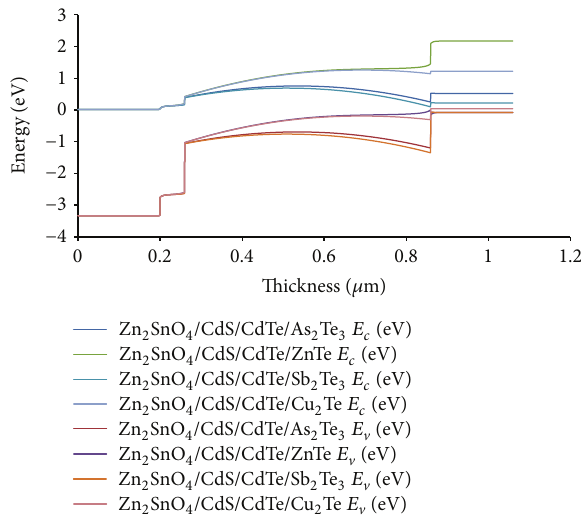
Figure9:Banddiagramoftheproposedcells(Zn 2 SnO 4 /CdS/CdTe/